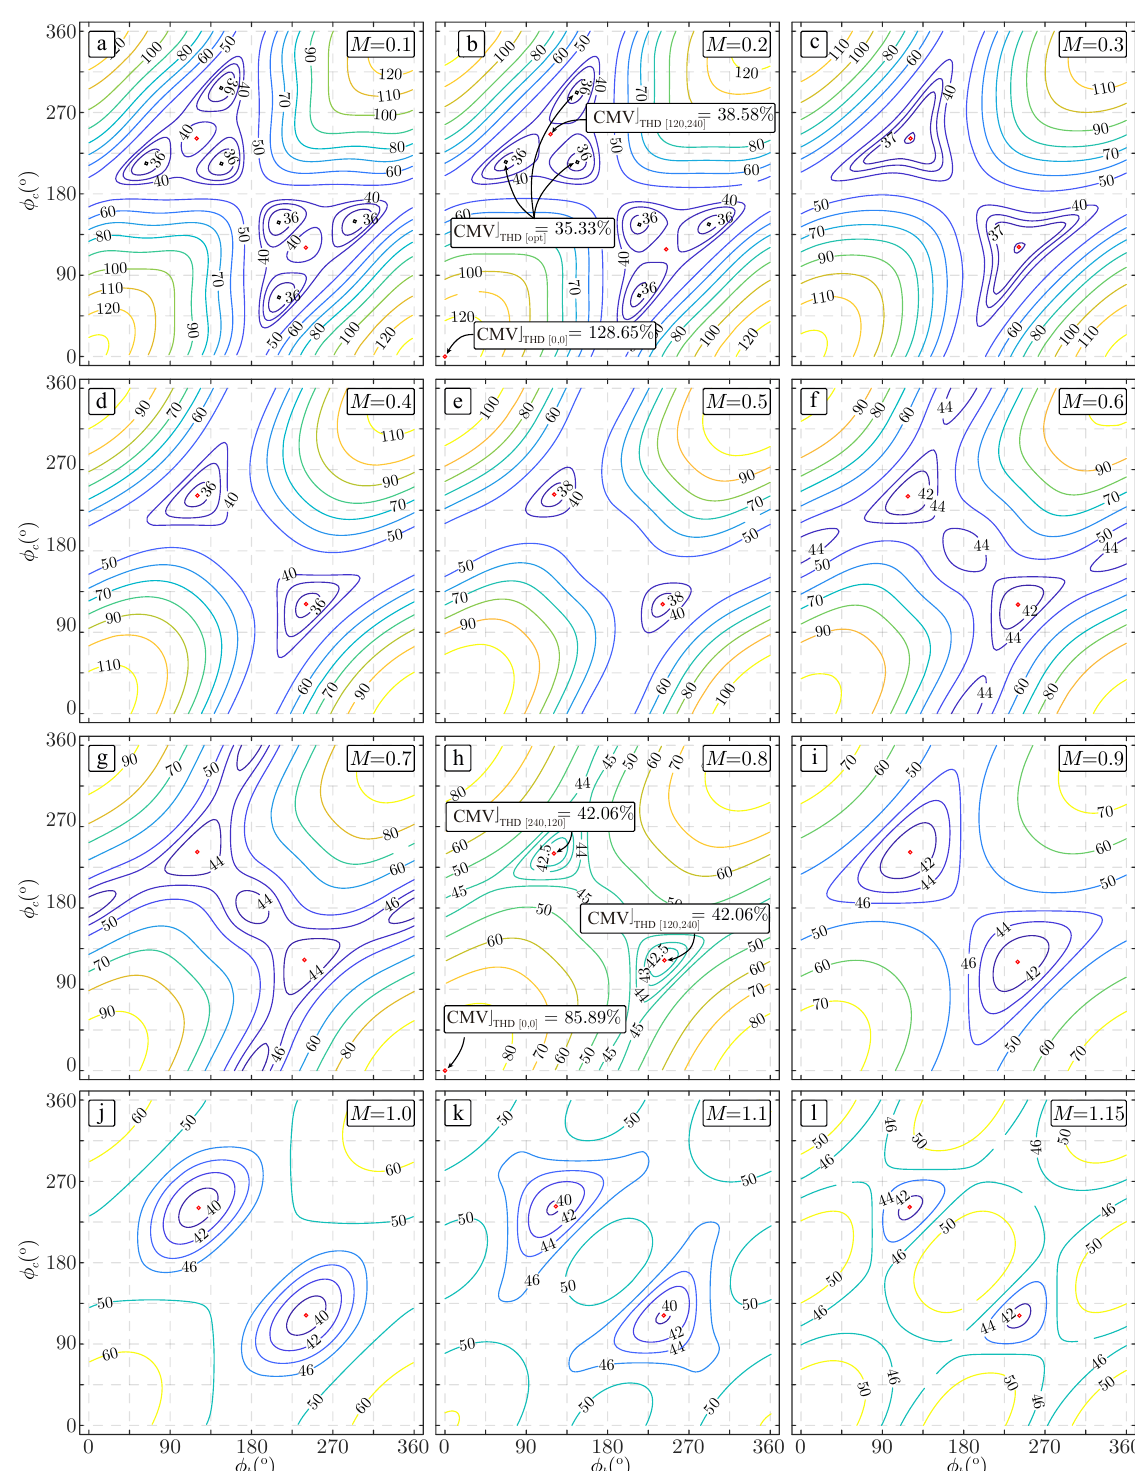
Figure 6. Evaluation of the CMV THD with different values of the modulation index ( a ) M = 0.1 ( b ) M = 0.2 ( c ) M = 0.3 ( d ) M = 0.4 ( e ) M = 0.5 ( f ) M = 0.6 ( g ) M = 0.7 ( h ) M = 0.8 ( i ) M = 0.9 ( j ) M = 1 ( k ) M = 1.1 ( l ) M =